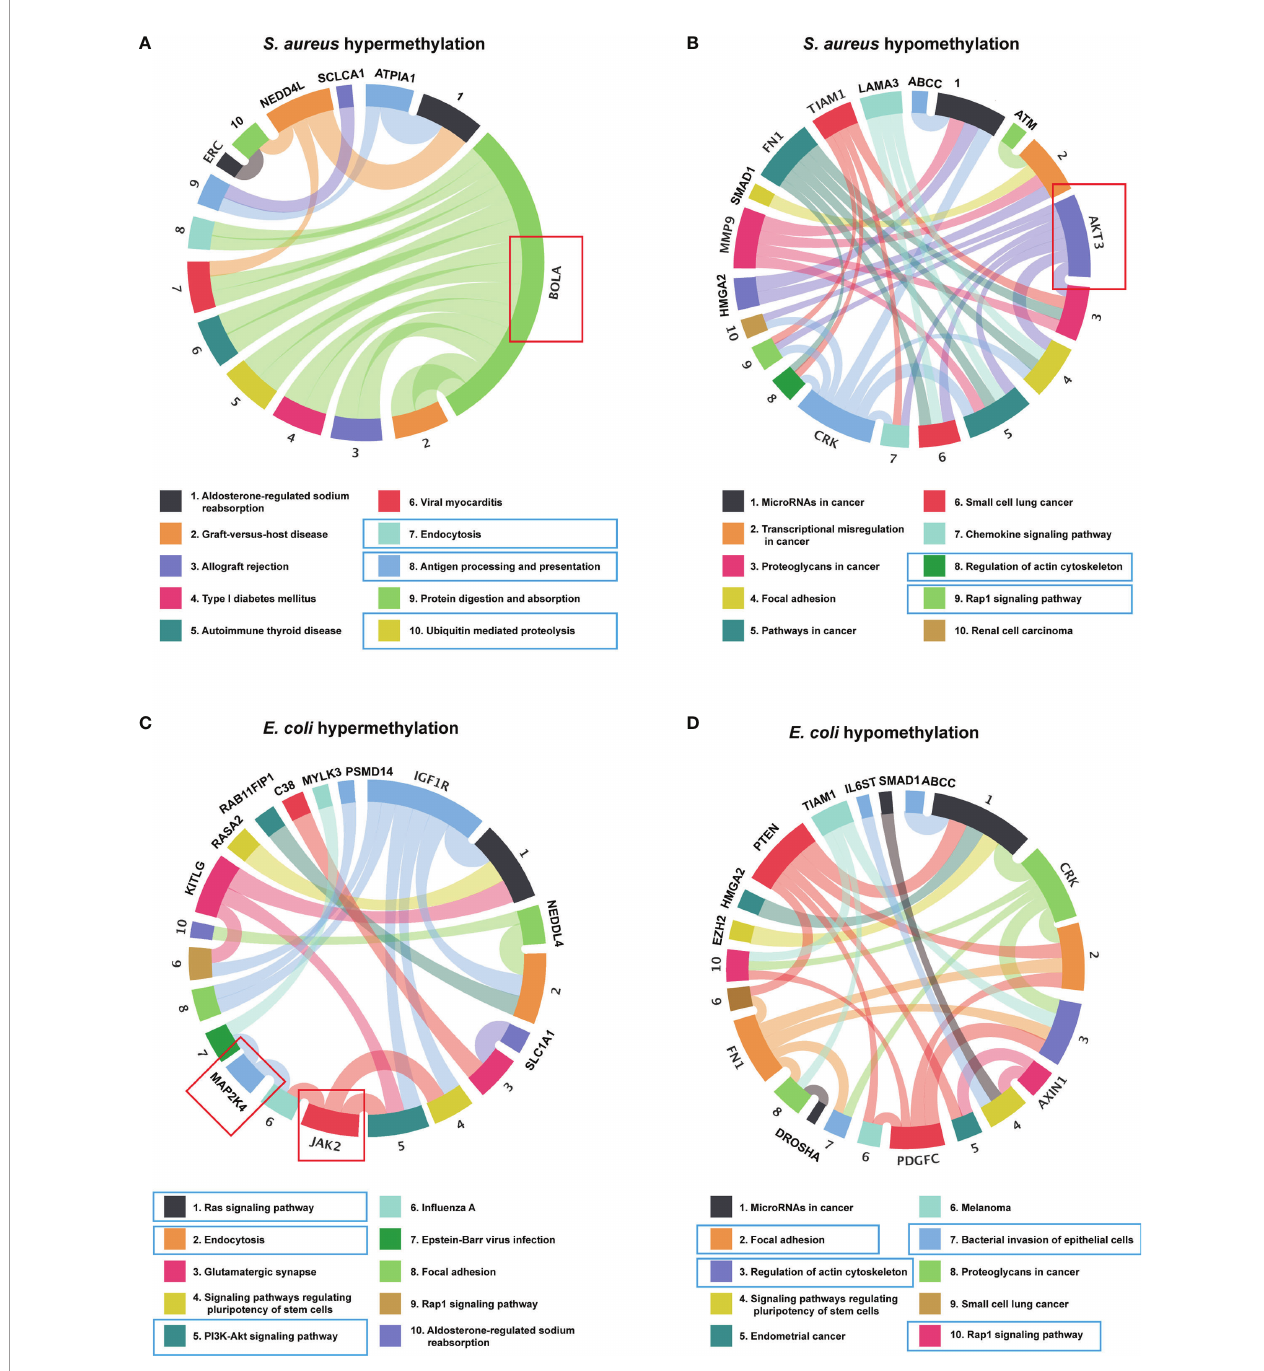
FIGURE 5 | KEGG enrichment analysis. (A) The top 10 KEGG pathway enriched for the source genes of differential circRNA with hypermethylation and (B) hypomethylation in the S. aureus group. (C) The top 10 KEGG pathway enriched for the source genes of differential circRNA with hypermethylation and (D) hypomethylation in the E. coli group (the predicted KEGG pathways in the blue box and representative genes in the red box were related to in fl ammation, apoptosis, and